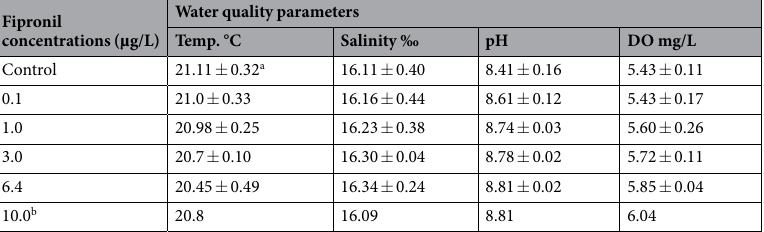
Table 1. Water quality parameters of the shrimp aquariums during 29 days of laboratory experiments. a Values of Mean ± standard deviation for each parameter of all concentrations (treatments) of fipronil used during the trials. b Values of fipronil concentration 10.0 µ g/L have no standard deviation due to shrimp mortality during first few days of the trial.